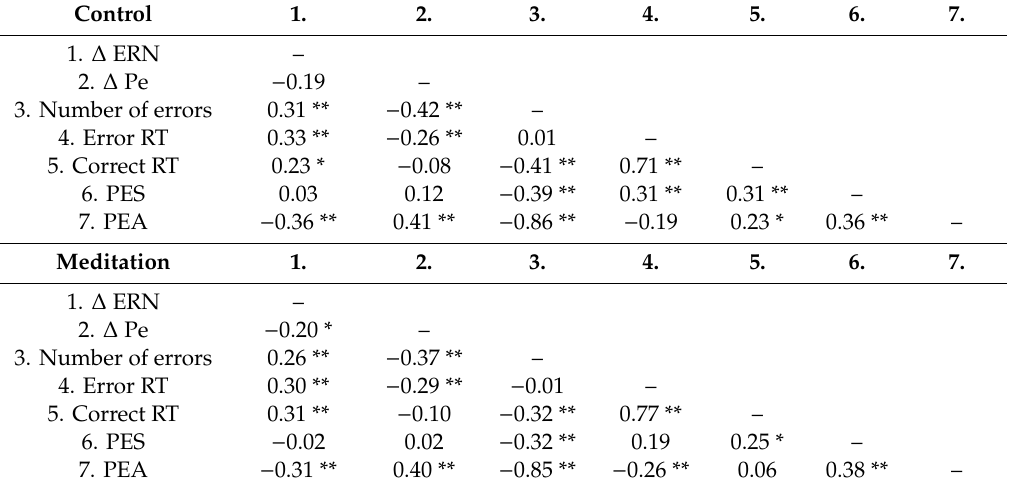
Table 3. Bivariate correlations among ERP measures and behavioral performance by group. Control